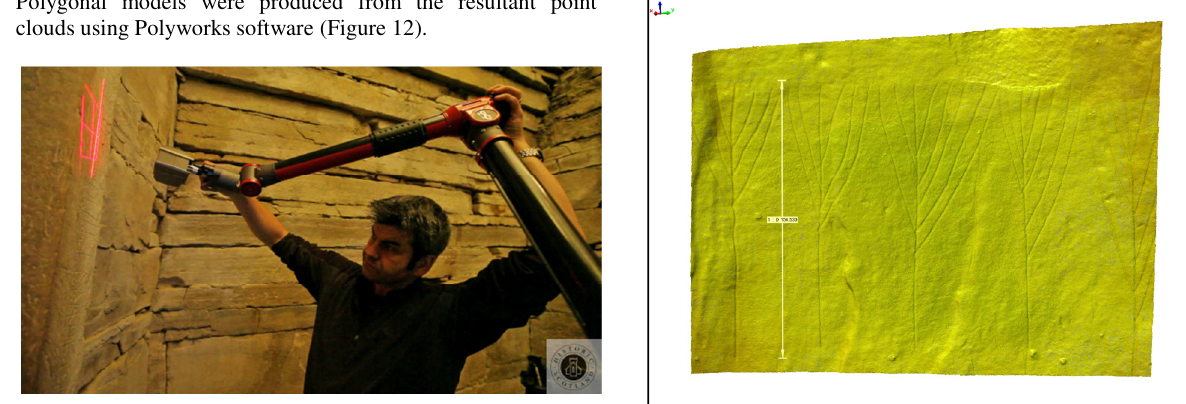
Figure 13. Quantitative error map from Maeshowe runic inscription, comparing high resolution laser scan data from 2003 and 2010 scanning epochs. Yellow indicates no erosion or accretion. The scale measures deviation from -0.800mm to +0.602mm © CDDV 2011.